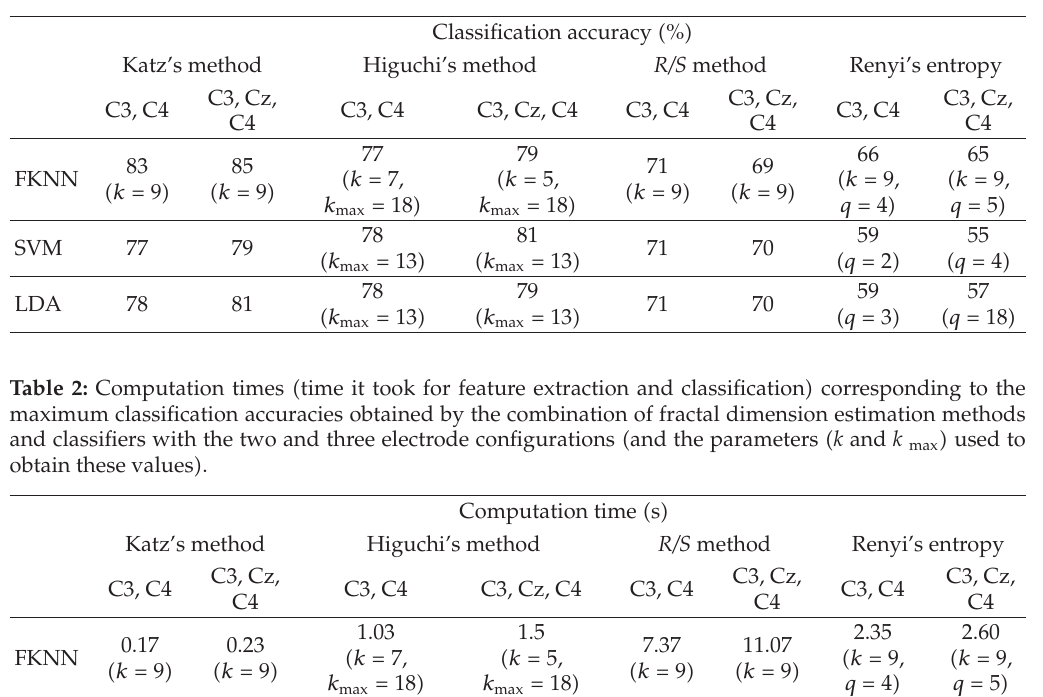
Table 1: Maximum classification accuracies (cid:4) percentage of correctly classified testing samples (cid:5) obtained by the combination of fractal dimension estimation methods and classifiers with the two and three electrode configurations (cid:4) and the parameters (cid:4) k and k max (cid:5) used to obtain these values (cid:5) .